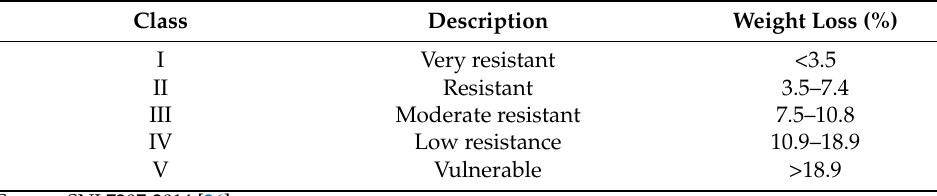
Table 4. The resistance class of wood against subterranean termites.